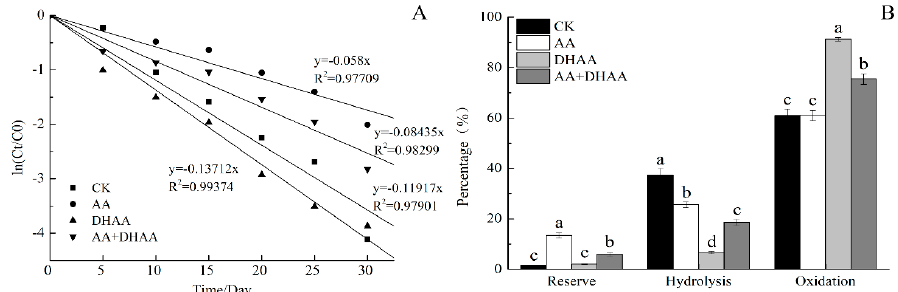
Figure 3. The effect of ascorbic acid (AA) and dehydroascorbic acid (DHAA) on the EGCG stability: ( A ) Apparent first-order kinetics of EGCG degradation of four incubation systems; ( B ) significant analysis of conversion pathway in different incubation systems. Date represent means ±SD of three replicate samples. Different letters indicate significant differences according to Duncan’s multiple range test ( p < 0.05).